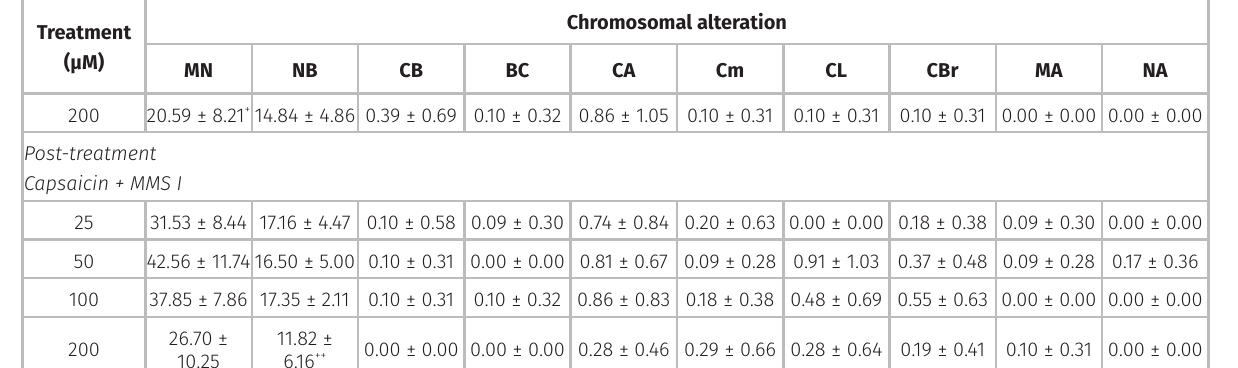
Table IV. Continuation. Treatment Chromosomal